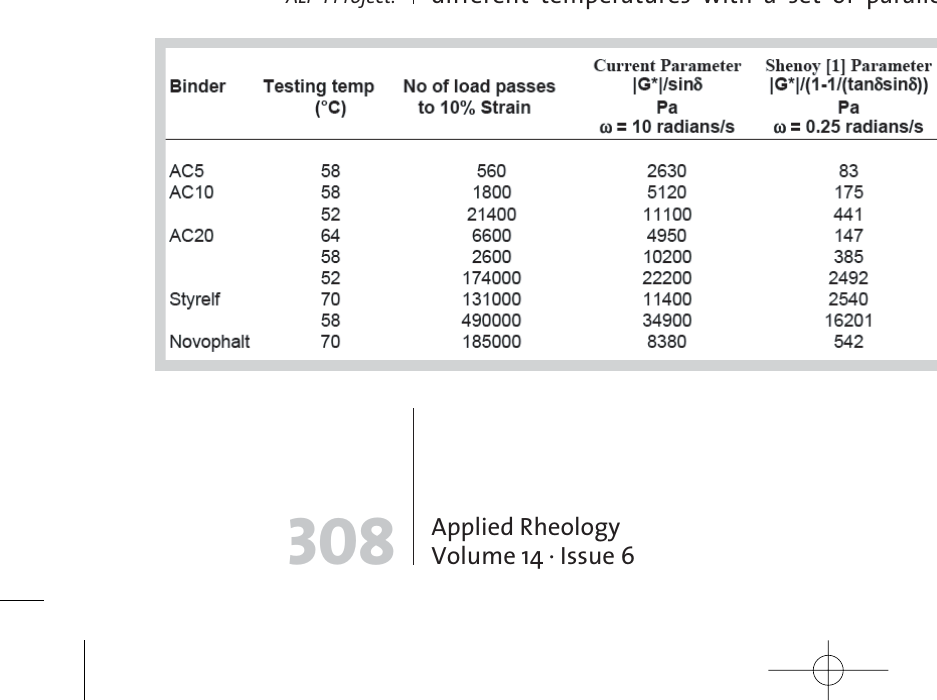
Table 1: Comparison of |G*| / sin d and |G*|/(1-1/(tan d sin d )) with number of load passes to 10% permanent strain for asphalt binders from the ALF-1